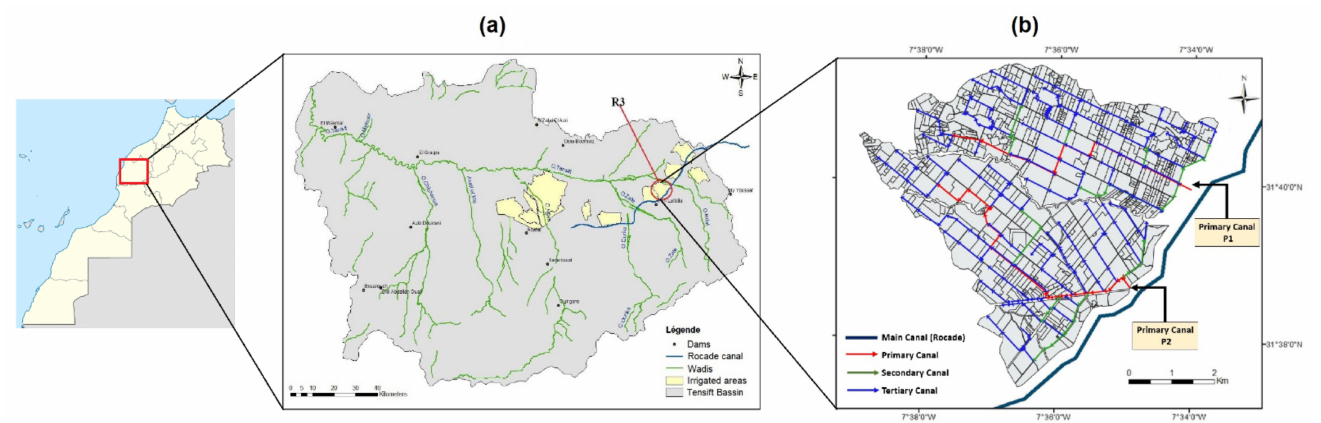
Figure 1. ( a ) Main irrigated sectors in the Tensift El Haouz basin; ( b ) the gravity irrigation network in the R3 study area. Water is provided to the R3 irrigated area from the “Hassan 1st dam” located in the